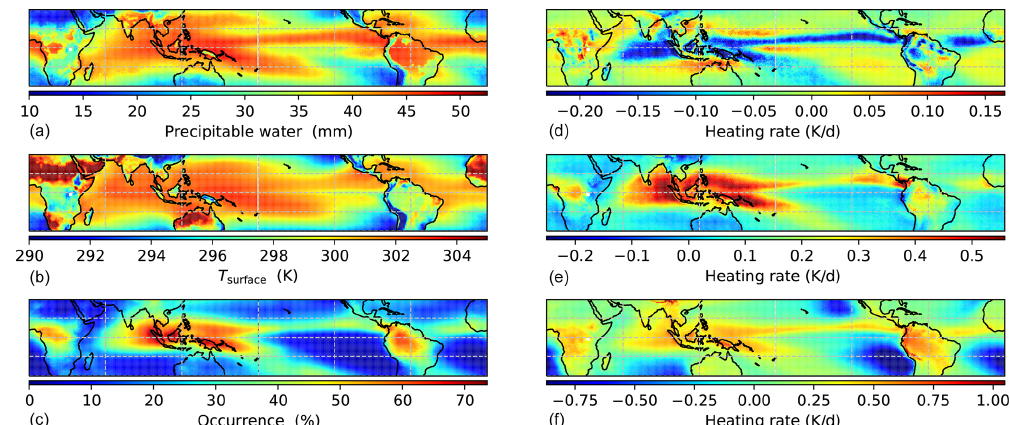
Figure 7. Geographical maps of total precipitable water and surface temperature from ERA-Interim and frequency of occurrence of UT clouds from CIRS-AIRS (a, b, c) and of 24h net cloud radiative heating effect in three atmospheric layers, integrated over 106 to 200hPa, over 200 to 585hPa and 585 to 900hPa (d, e, f) . Statistics of 16 years (2003–2018).